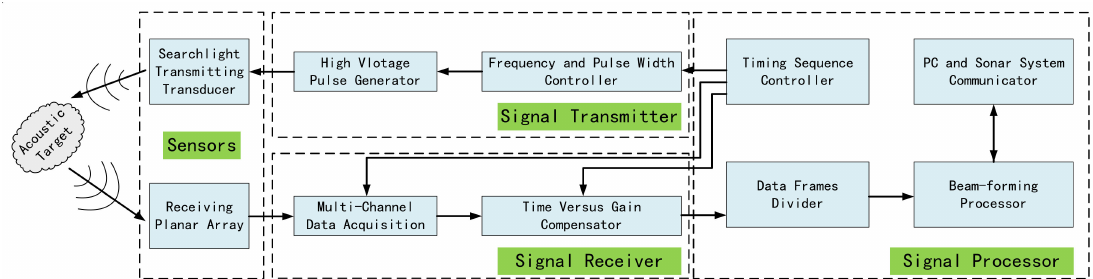
Figure 1. The architecture of multibeam